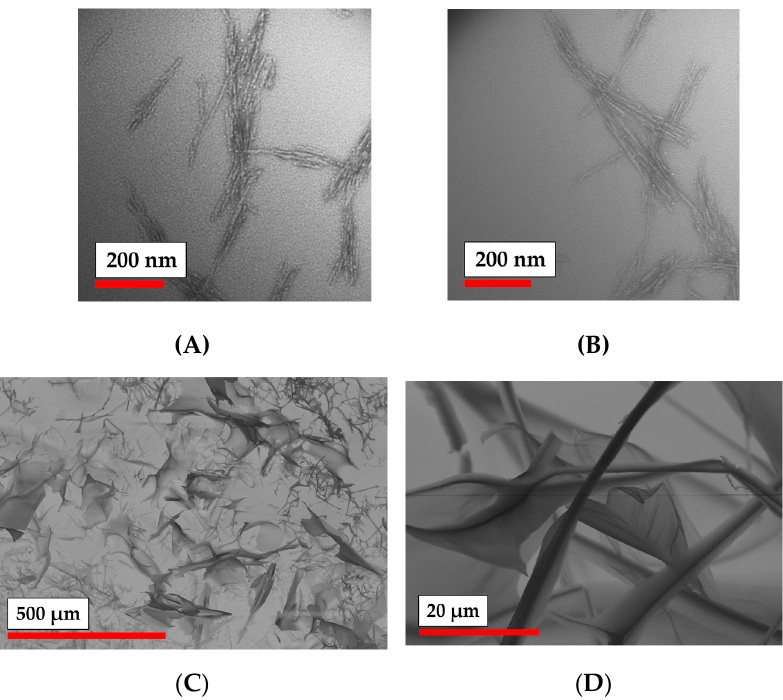
Figure 5. Morphology of NCC particles: ( A ) TEM images of non-modified NCC particles; ( B ) TEM